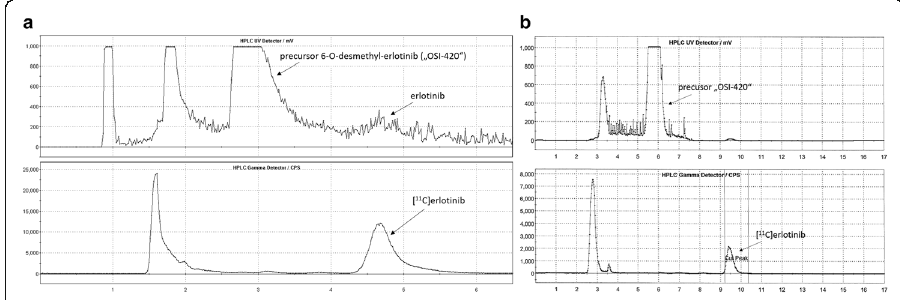
Fig. 3 Semi-preparative chromatogram of the reaction solution of [ 11 C]erlotinib (top: UV-channel; bottom: radioactivity-channel) for method 1 ( a ) and method 2 ( b ). Note that flow rate was 8 mL/min for method 1 and 2.5 mL/min for method